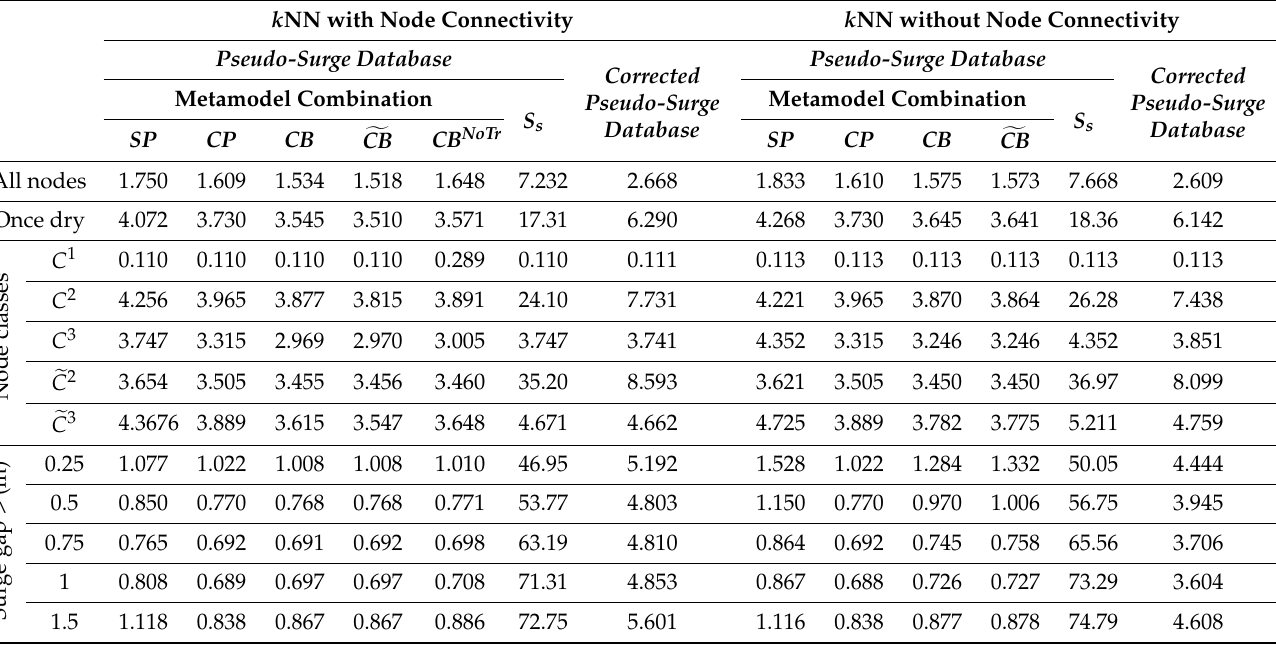
Table 4. Misclassification MC (%) averaged across different groups of nodes for different surrogate